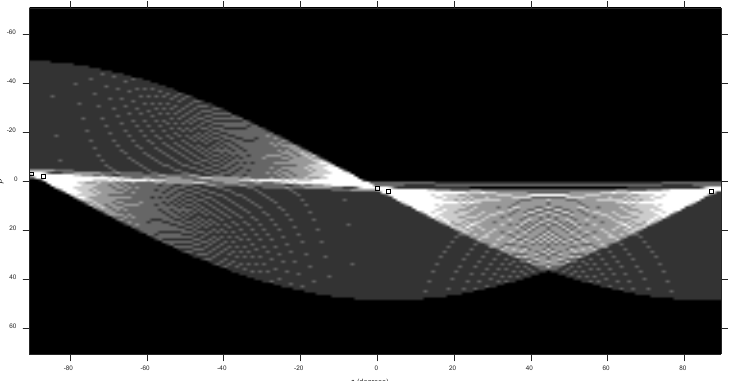
Figure 3. Line representation in Hough space.